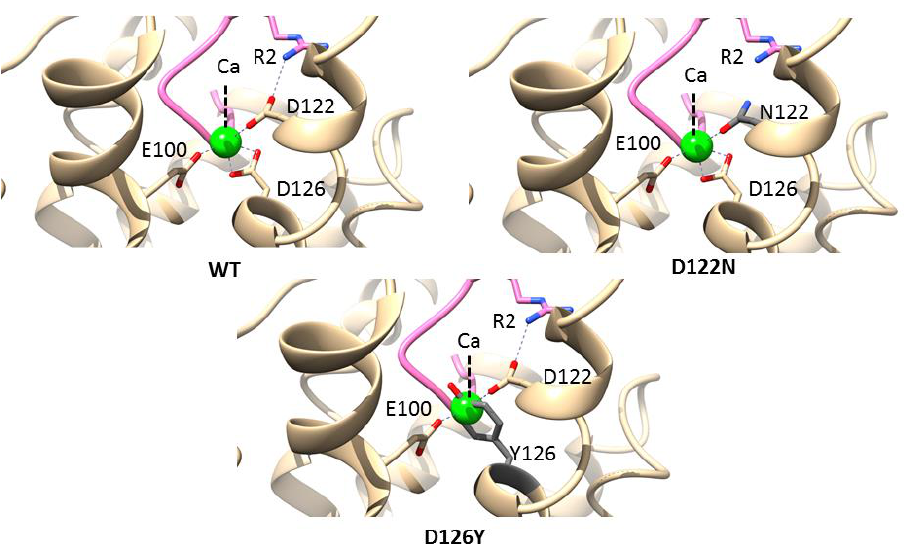
Figure 4. Mutations in the calcium-binding site. A structural view of the calcium ion-binding pocket (PDBID: 7AUE), highlighting the interactions between the calcium ion (green) and MC4R (tan). Residues from helices II and III of MC4R, especially the negative charges from glutamate and aspartate, coordinate with calcium ( left panel ). A mutation at position 122 from aspartate to asparagine (D122N) would hamper electrostatic interactions with the ligand ( right panel ). Similarly, a mutation at position 126 from aspartate to tyrosine (D126Y) would collapse the active site structure due to the bulkier aromatic sidechain of tyrosine, which sterically clash with calcium ( lower panel ).